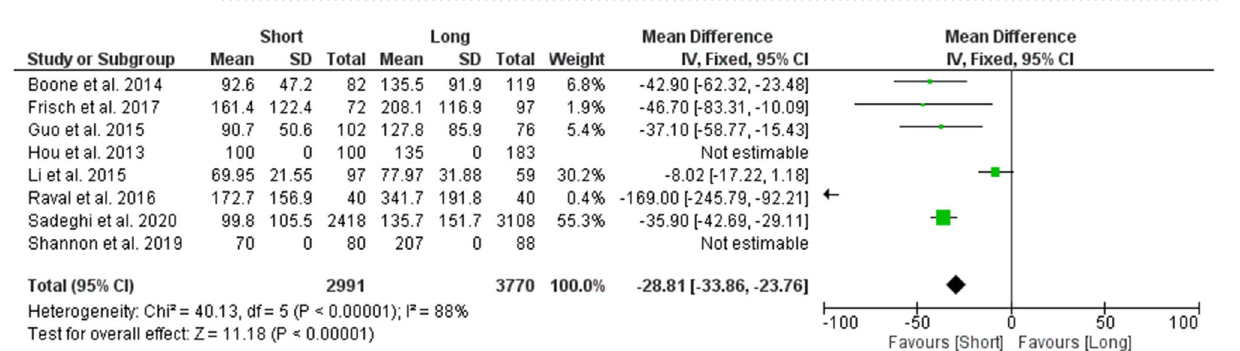
Figure 3. Forest plot of mean operating times between long and short CMD groups. Green boxes represent weighted mean values of each study. The black diamond represents the overall pooled weighted mean of all included studies.